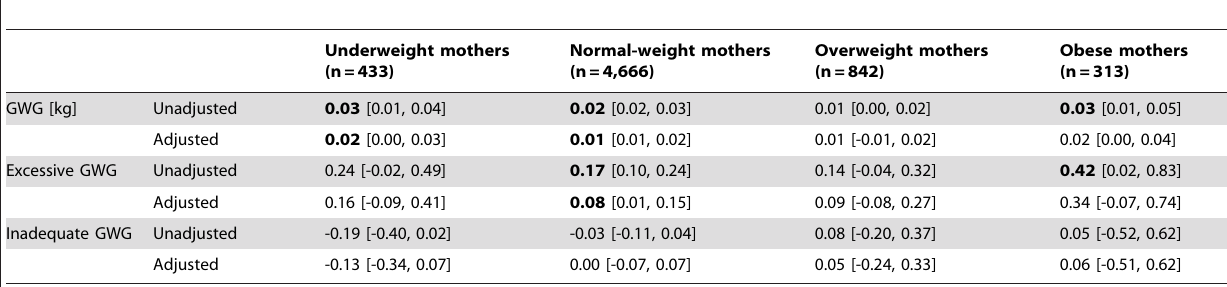
Table 2. Linear regression estimates [95% confidence intervals] for the association of total, excessive and inadequate gestational weight gain (GWG) with offspring’s BMI SDS at 5–6 years.